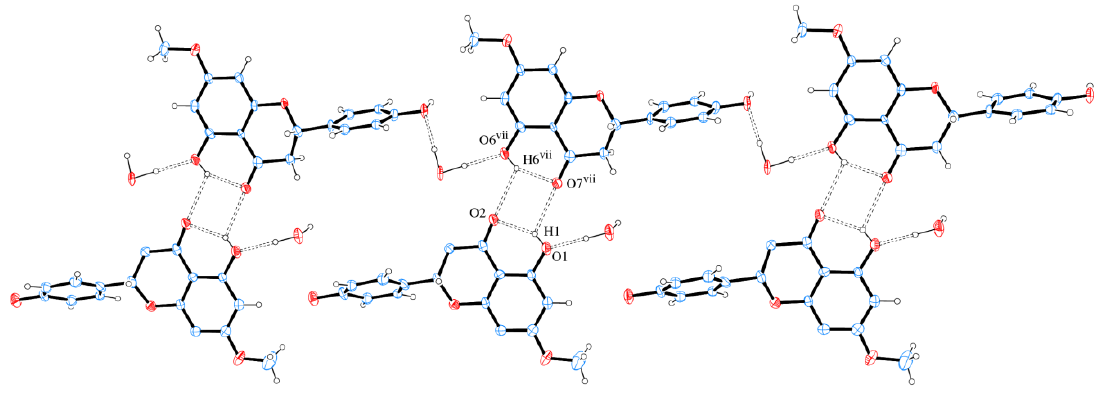
Figure 9. A section of the supramolecular double chain of sakuranetin-monohydrate projected onto (104) with double chain propagation along [010]. Hydrogen bonds are shown as dashed lines. Displacement ellipsoids are drawn at the 30% probability level.